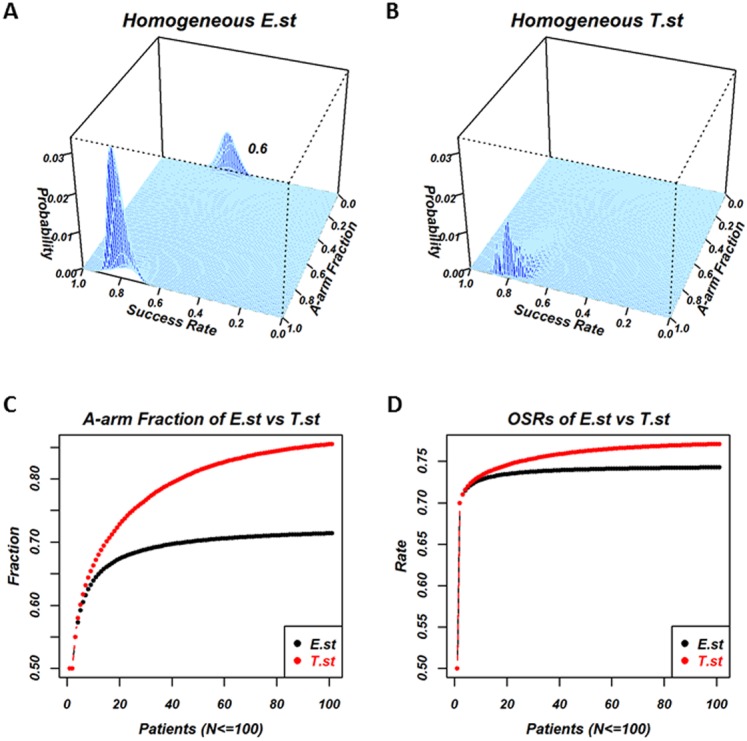
Comparison of a homogeneous population with E-strategy (E.st) and a homogeneous population with T-strategy (T.st) when the true success rates of A and B were 0.8 and 0.6 and the optimistic attitude index of T.st was 0.5.(A) and (B) show the results when 100 patients’ outcomes have been recorded for E.st and T.st, respectively. Each panel is the two-dimensional histogram where the cyan area indicates the support plane and one axis “Success rate” indicates the overall success rate for 100 patients and the other axis “A-arm Fraction” indicates the fraction of patients who selected treatment A. The vertical axis indicates the exact probability of occurrence in the stochastic process. (A) for E.st shows two peaks; one peak’s overall success rate was around 0.8 and its A-arm fraction was close to 1 and the other peak’s overall success rate was around 0.6 and its A-arm fraction was close to 0. The first peak was higher than the other peak. These findings indicated that the majority of individuals with E.st selected treatment A in many occasions but that in some occasions, they selected treatment B rather than treatment A. (B) for T.st shows one peak and its overall success rate was around 0.8 and its A-arm fraction was close to 1. The mountain in (B) was lower than the mountain located nearby in (A). These findings indicated that the majority of individuals with T.st selected treatment A in almost all the occasions, although the A-arm fraction tended to be lower than E.st. (C) and (D) show how the two measures change based on the homogeneous E.st versus T.st while the patient number changed, N = 1, 2, …, 100, and horizontal axis shows the patient’s number, and vertical axis shows the measure “A-arm fraction” in the (C) and the measure “overall success rate (OSR)” in the (D), where homogeneous E.st is labeled in black and T.st is in red.